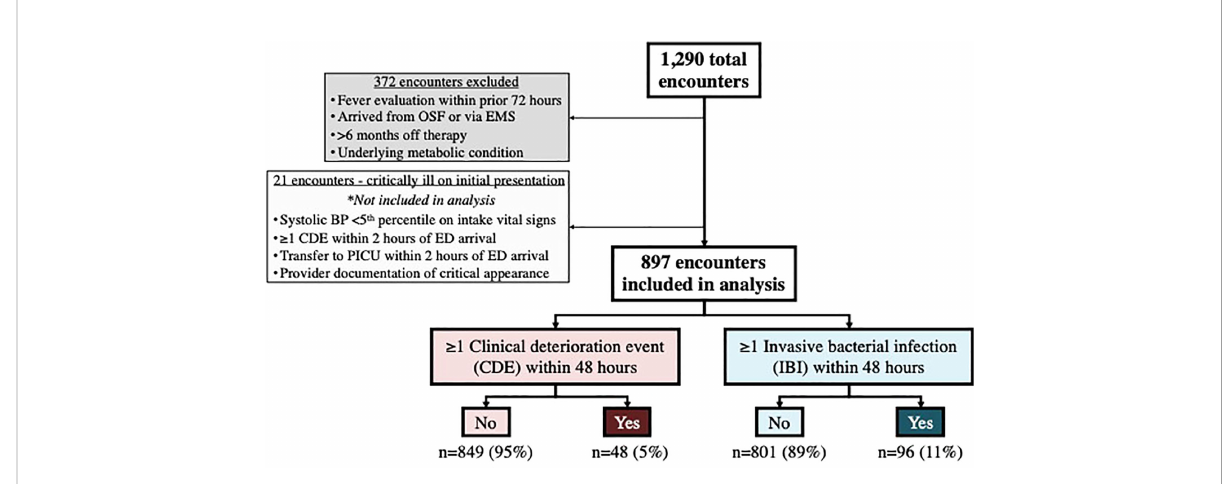
FIGURE 1 Study fl owchart. OSF, Outside facility; EMS, Emergency medical services; BP, Blood pressure; CDE, Clinical deterioration event; ED, Emergency department; PICU, Pediatric intensive care unit; IBI, Invasive bacterial